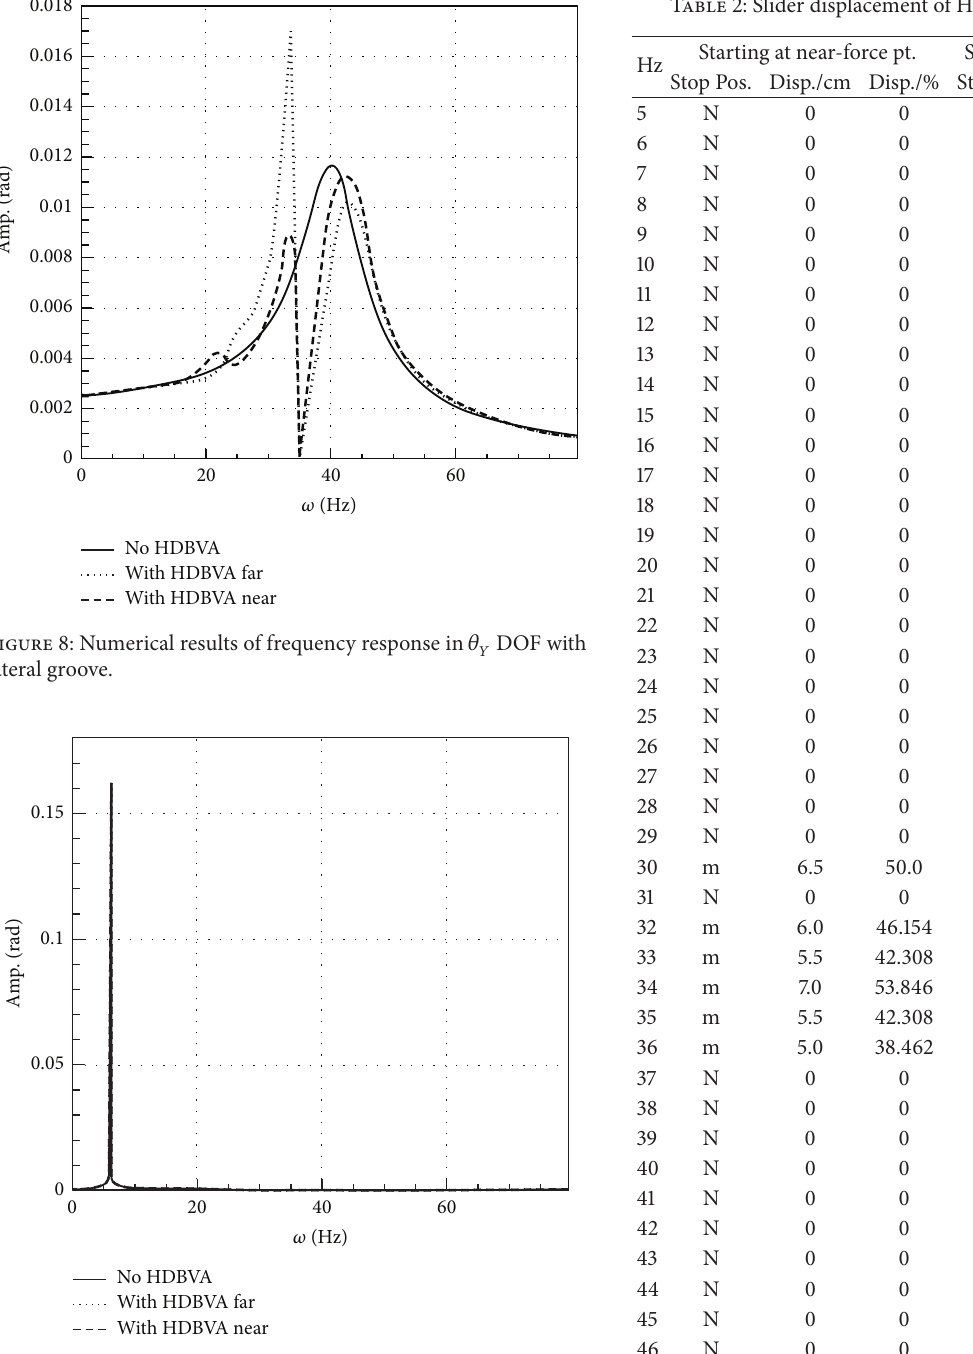
Table 2: Slider displacement of HDBVA1 in lateral groove.